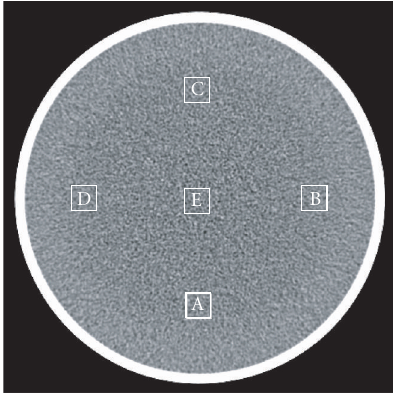
Figure 5: The schematic diagram showing the ROIs in the tomo- graphic image of the 20 cm water phantom to gauge noise charac- teristics: ROI A, B, C, D, and E are square consisting of 30 × 30 pixels; the center of ROI A, B, C, and D is 67 . 5mm from the iso, while the center of ROI E is at the iso.